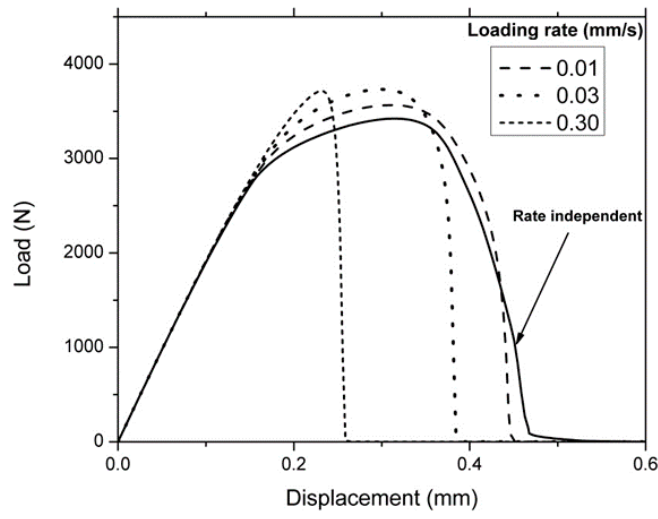
Figure 6. Effect of loading rate on the load displacement response for the V ‐ notched sample in tension.